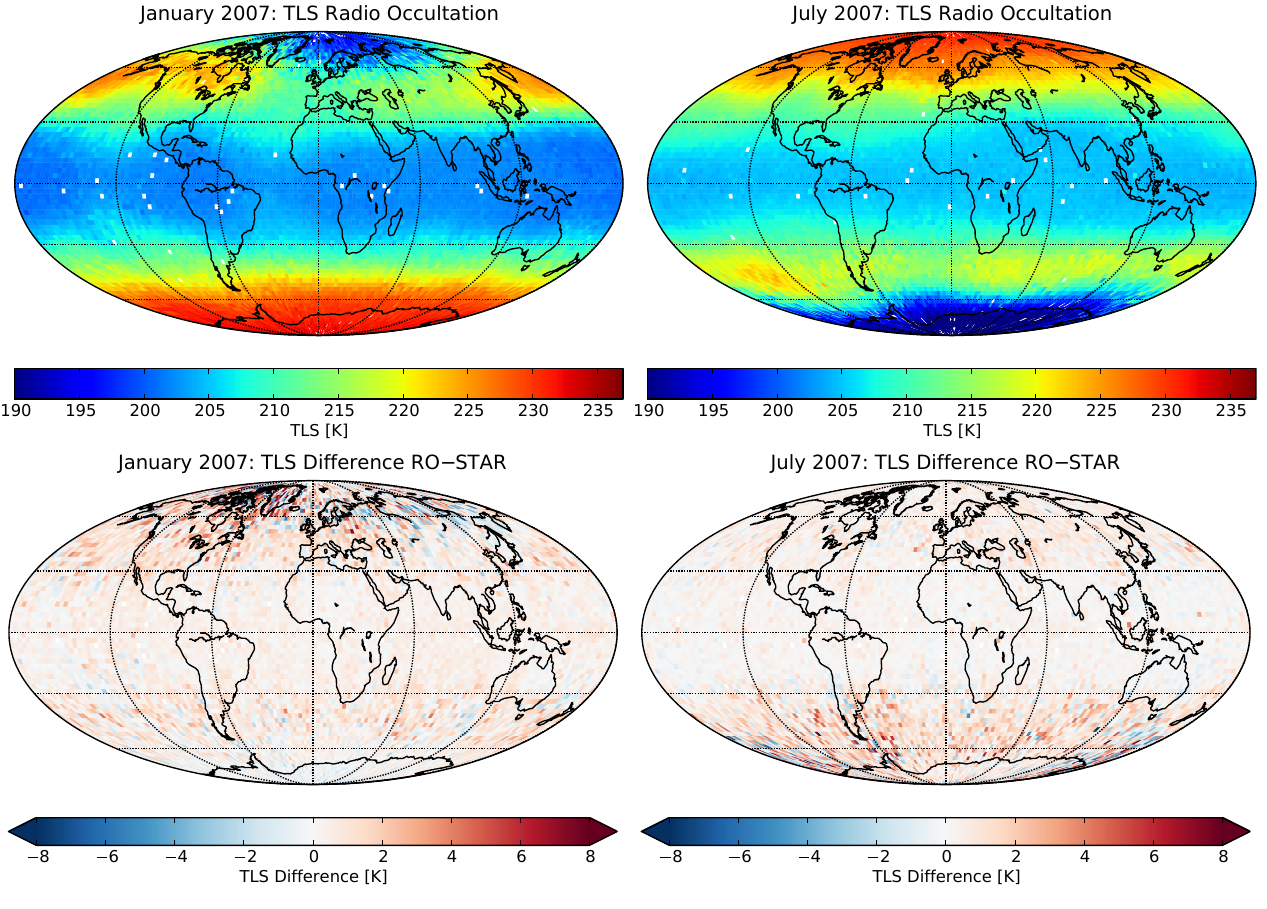
Fig. 4. Brightness temperatures (TLS) for two monthly means at 2 . 5 ◦ × 2 . 5 ◦ resolution. (left) January 2007, (right) July 2007, (top) Radio occultation synthetic TLS, (bottom) Difference of RO synthetic TLS to AMSU TLS